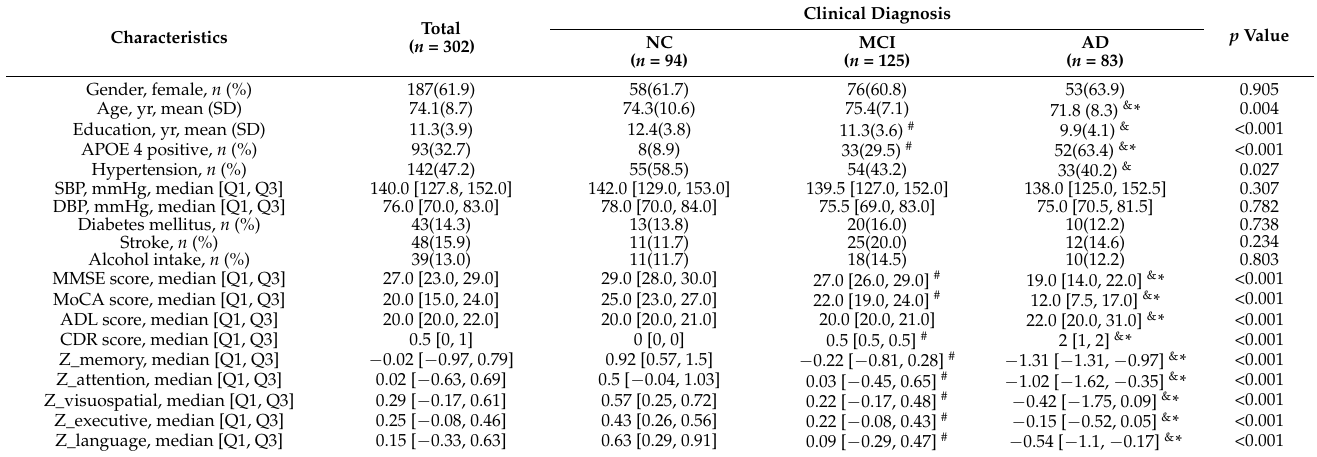
Table 1. Demographic and clinical characteristics among study